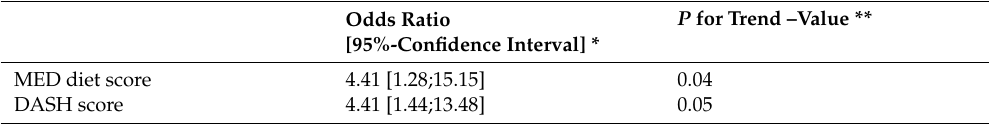
Table 7. Associations between diet quality scores and NAFLD ( n =